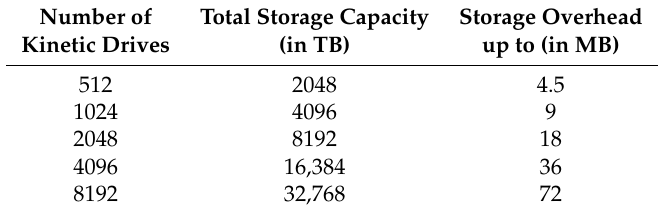
Table 3. Storage Capacity and Overhead of a Region (4 TB per